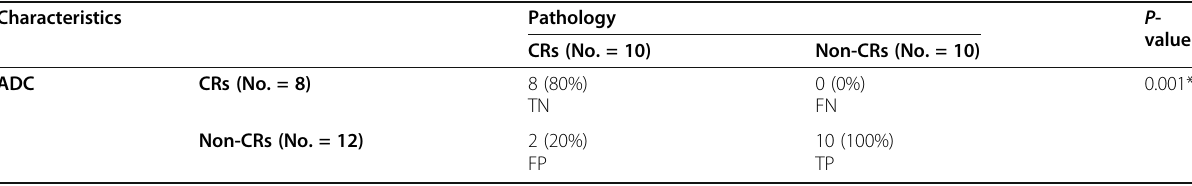
Table 4 ADC versus pathology in the studied group Characteristics